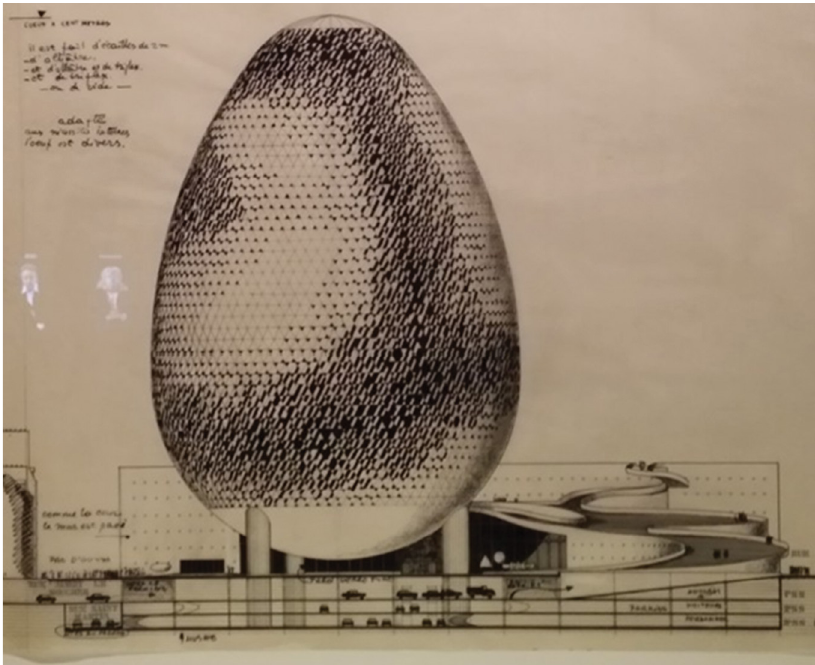
Figure 9. André Bruyère [France], 1971. Project n°272. The project was marked with an “A” by at least one member of the Jury during the first phase of the competition (7/7/71), which made it immediately eligible for a full review by the rest of the Jury. According to the notes available, the project was eliminated after the second review (12/7/71). (Chaslin, François, and Eve Roy. André Bruyère : La Tendresse des Murs. Paris: Editions du patrimoine, Centre des monuments nationaux,